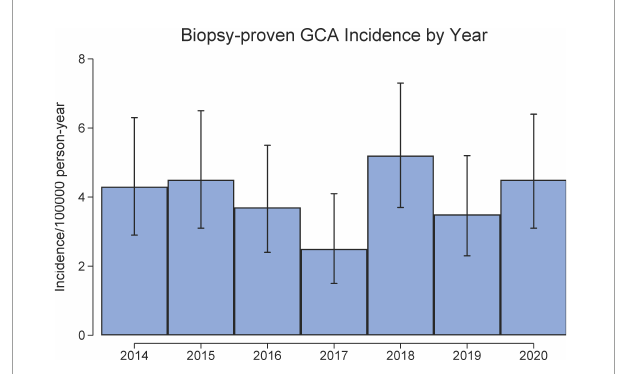
FIGURE2 Incidence of biopsy-proven GCA in South Australia